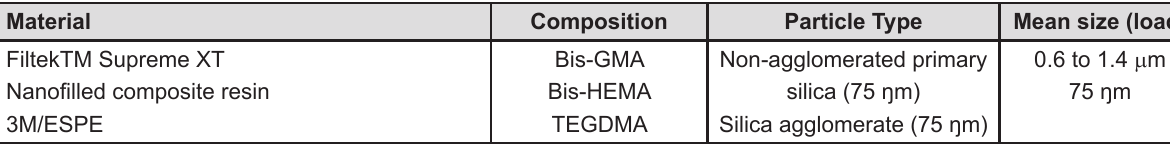
Figure 1- Composite resin characteristics